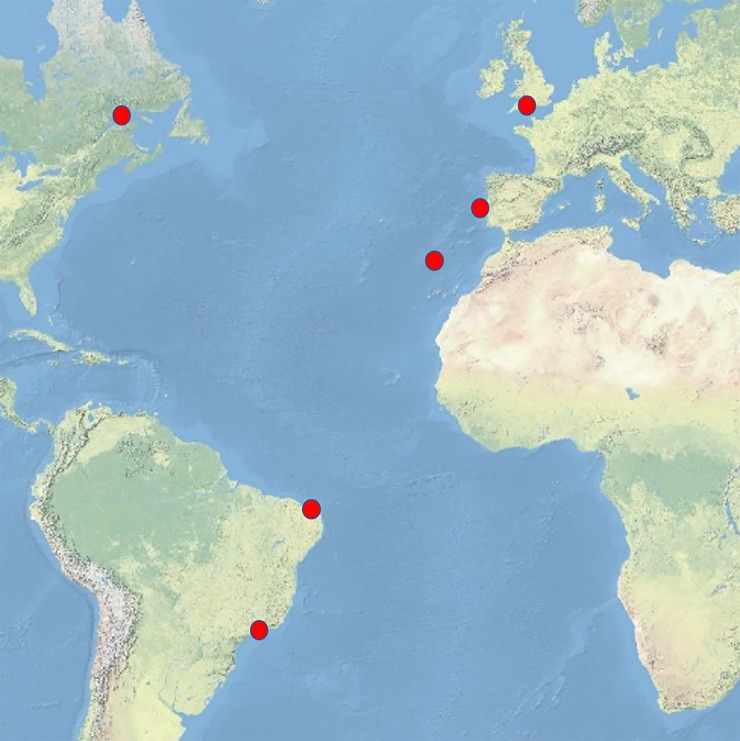
Location of the sampling sites.Red dots mark the location of the sampling sites.